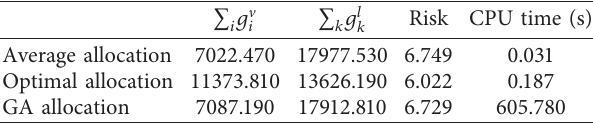
Table 4: Comparison of the three optimization allocation